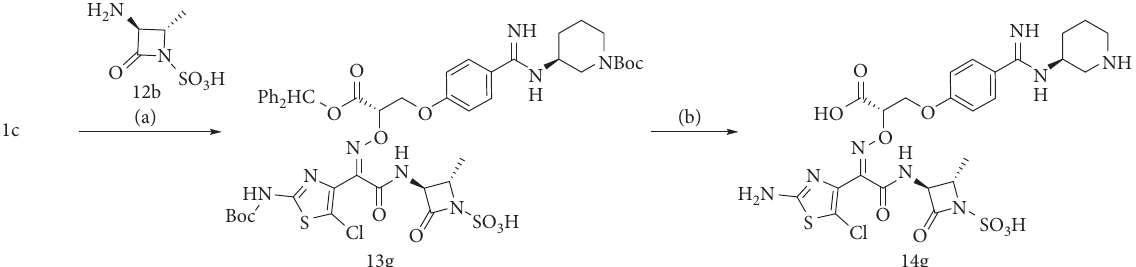
Scheme 3: Synthesis of compound 14g . Reagents and conditions: (a) 12a , HOBT, DCC, NaHCO – rt,